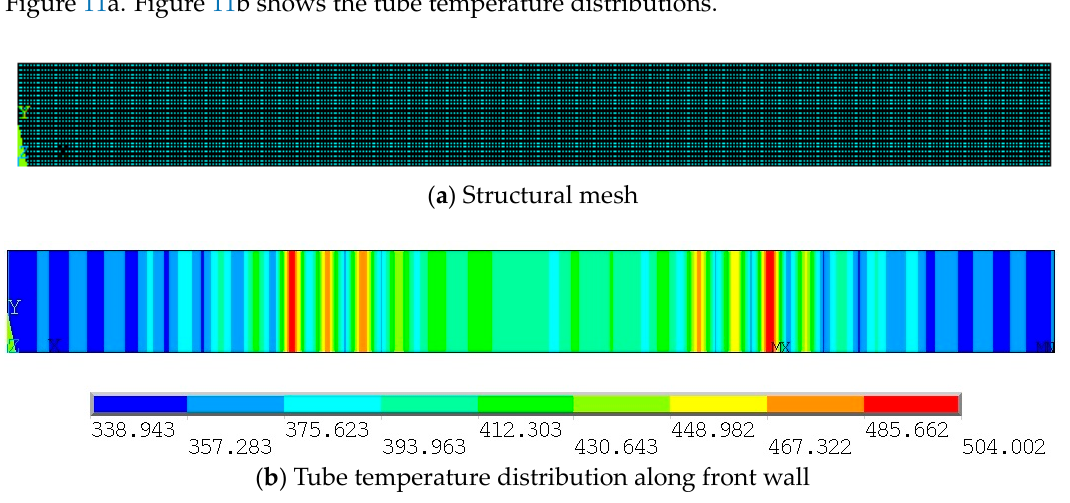
Table 3. Physical properties of 15CrMoG